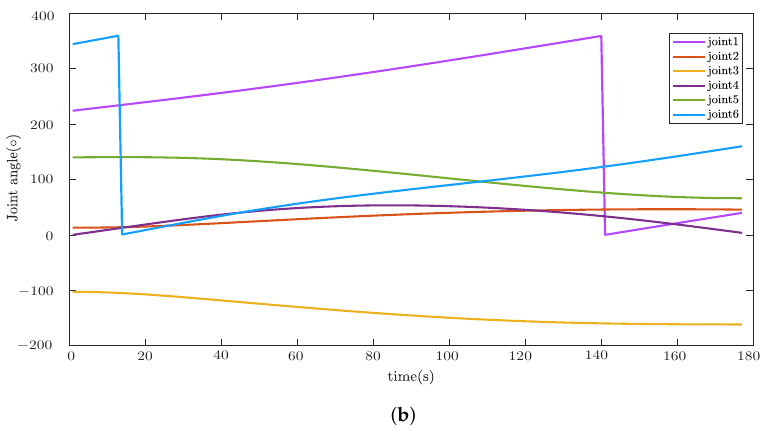
Figure 11. Joint motion results for initial and optimized solution during trajectory tracking task. ( a ) Joint motion of initial solution; ( b ) Joint motion of optimized solution.